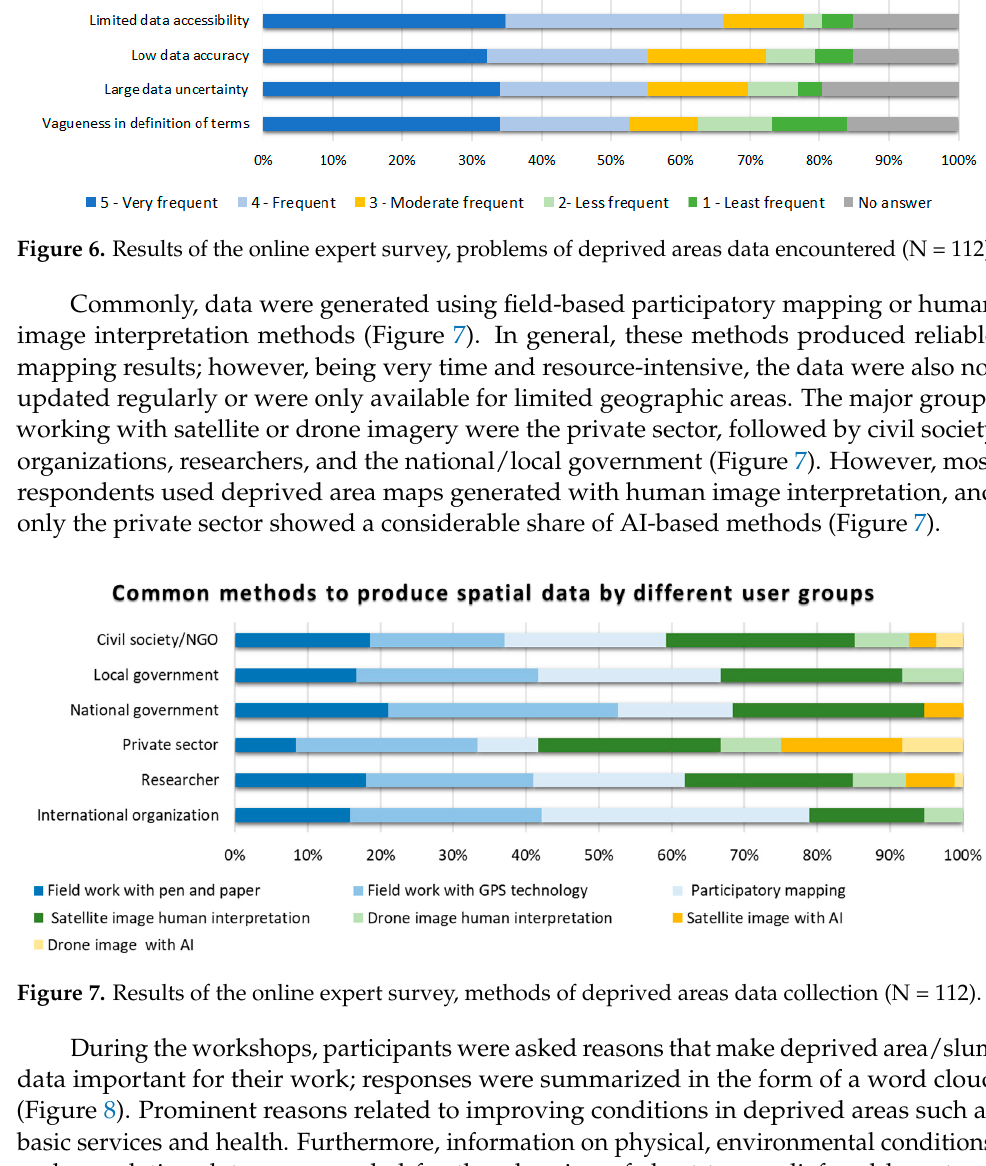
Figure 8. Word cloud of participants of several workshops (using Mentimeter) asking for reasons why deprived area related data are needed. During expert interactions, the chronic lack of base data (e.g., data about buildings and roads/paths) was strongly expressed. Available maps were often outdated and cov- ered only part of the city. Moreover, data beyond the administrative city boundary (i.e., suburban and peri-urban areas) were often reported as highly dynamic with sparser data coverage. The missing data problem was also strongly stressed by CBOs, which have be- come more visible during the COVID-19 pandemic [5,46,47]. These missing data reported as needed at the community level, included updated population numbers to evidence and communicate about populations in need of food supply, data on health and other services, and environmental conditions such as those that contribute to health risks (e.g., the accu- mulation of waste piles—a problem that became even more acute during the COVID-19 lockdowns [47,48]). Furthermore, data needs for open spaces and their physical character- istics have been expressed to inform pro-poor policies.